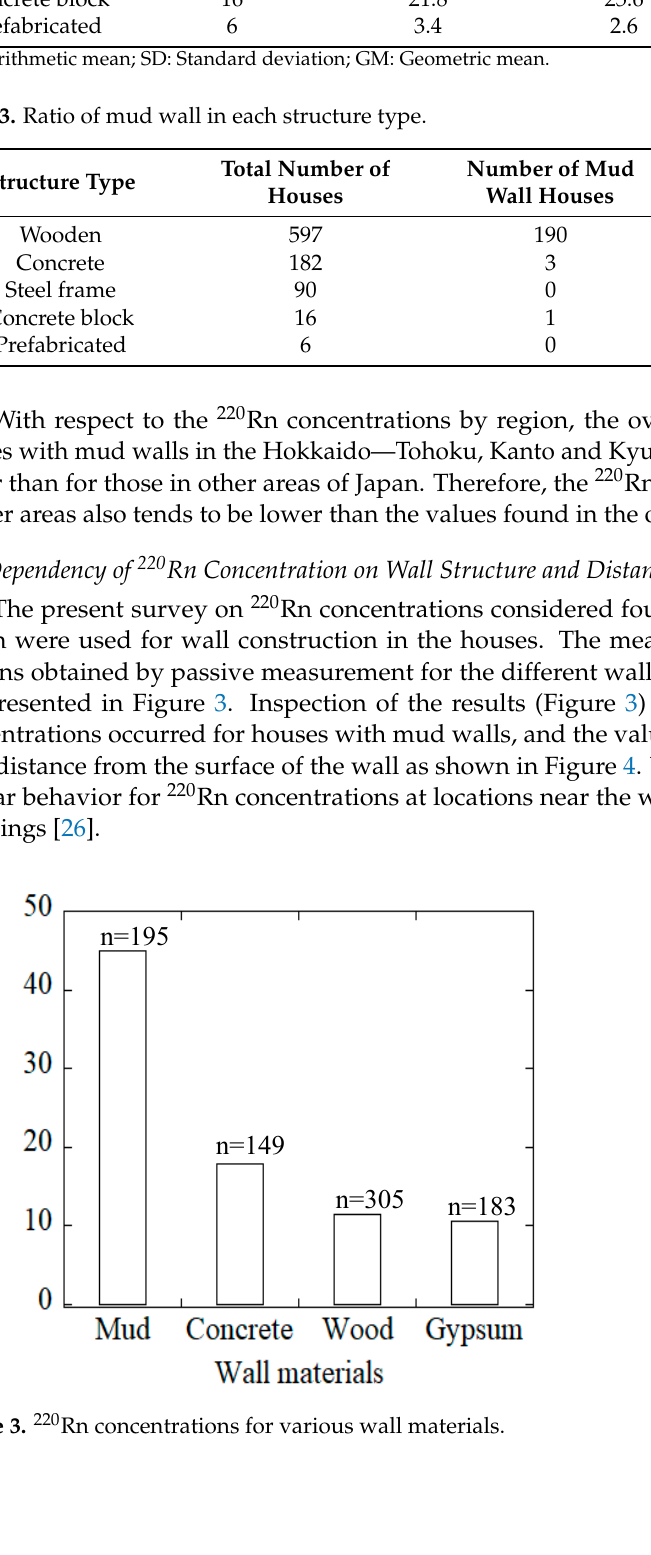
Figure 4. 220 Rn concentrations at different distances from the wall surface for all wall materials. 3.5. 220 Rn and 222 Rn Correlation The correlation between the indoor 220 Rn and 222 Rn concentrations was investigated. The relationship between the 220 Rn and the 222 Rn concentrations is illustrated in Figure 5. The concentration distributions for both radioisotopes follow approximately a log-normal distribution. Consequently, both datasets were calculated after taking the logarithms of the respective data. The linear regression analysis shows a weak positive correlation (R = 0.25). The ratio for the concentrations of 220 Rn/ 222 Rn ranged from 0.007 to 40.3 and reveal a log-normal plot. The arithmetic mean for 220 Rn/ 222 Rn was 1.64 and geometric mean was 0.78.